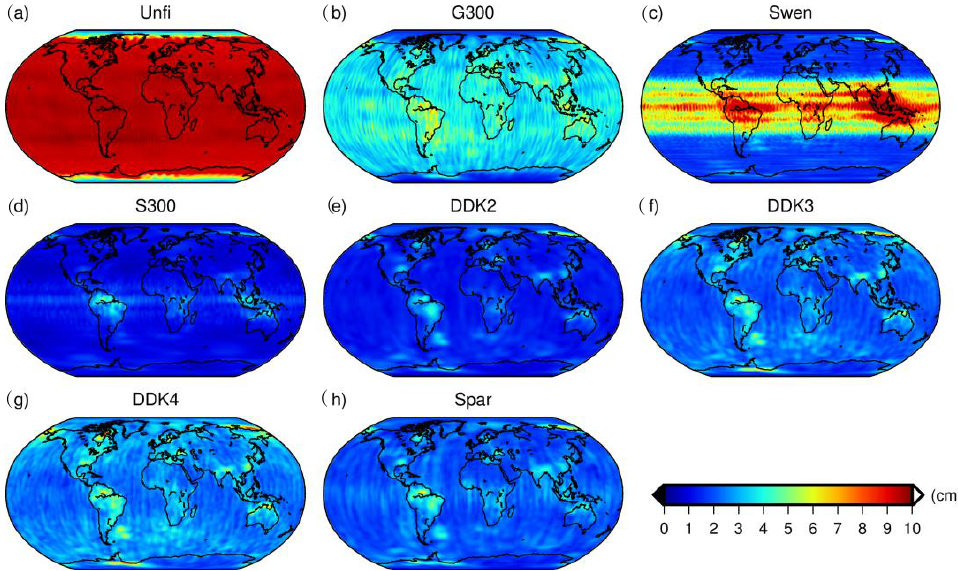
Figure 9. Noise StD for the eight filtered solution time-series under consideration estimated at the nodes of a global 1° × 1° grid with the VCE method.